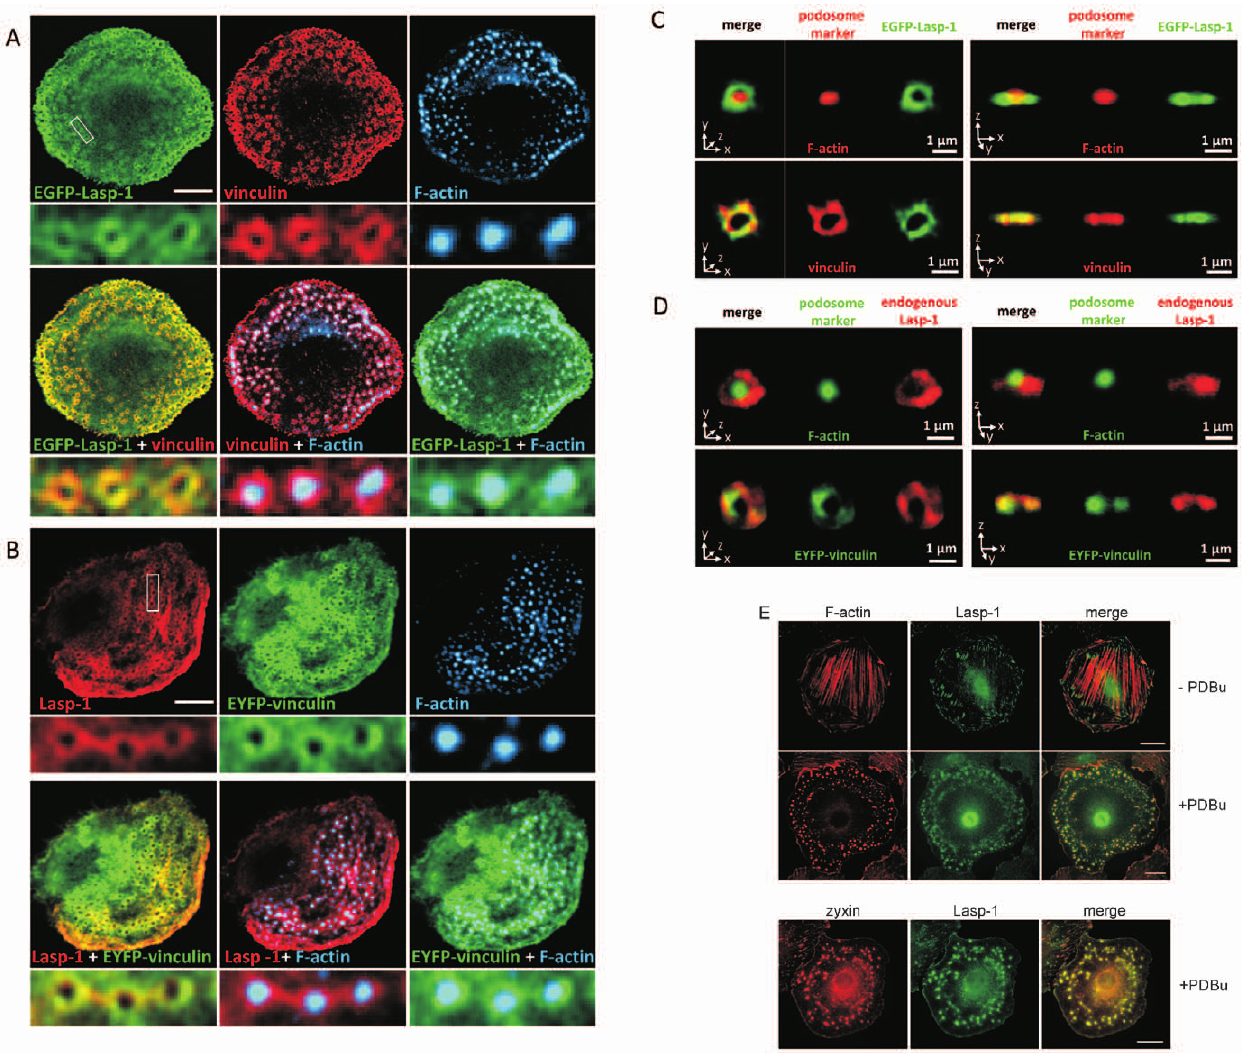
Figure 1. Lasp-1 is a component of the podosome ring structure. ( A, B ) Confocal micrographs of primary human macrophages transfected with constructs encoding (A) EGFP-Lasp-1 and (B) EYFP-Vinculin (green), respectively, and stained with vinculin- or Lasp-1-specific antibodies (with Alexa488- or Alexa 568-conjugated secondary antibody) for endogenous vinculin or Lasp-1, respectively, and Cy5-conjugated phalloidin for F-actin (blue). White box indicates detail images below. Bars represent 10 m m. ( C, D ) 3D reconstruction of single podosomes of primary human macrophages. Left panels: xyz mode, right panels: xzy mode for the same podosome. (C) Cells were transfected with EGFP-Lasp-1 and stained with Alexa568-phalloidin for F-actin (podosome core) or vinculin-specific antibody (with Alexa568-labeled secondary antibody) for vinculin (podosome ring structure; red). (D) Both untransfected cells (stained with Alexa488-phalloidin for F-actin; green) and cells transfected with EYFP-vinculin (green) were stained with Lasp-1-specific antibody (with Alexa568-labeled secondary antibody) for endogenous Lasp-1 (red). ( E ) Confocal micrographs of a rat smooth muscle cell (A7r5), stained with Alexa-594 phalloidin for F-actin (red, upper panel) or zyxin-specific antibody (with Alexa594-labeled secondary antibody) for endogenous zyxin (red, lower panel) and co-stained with Lasp-1-specific antibody (with Alexa488-labeled secondary antibody) for endogenous Lasp-1 (green). Lasp-1 and its binding partner zyxin colocalize at F-actin-rich podosomes (merge) in PDBu-treated A7r5 cells. Bars represent 25 m